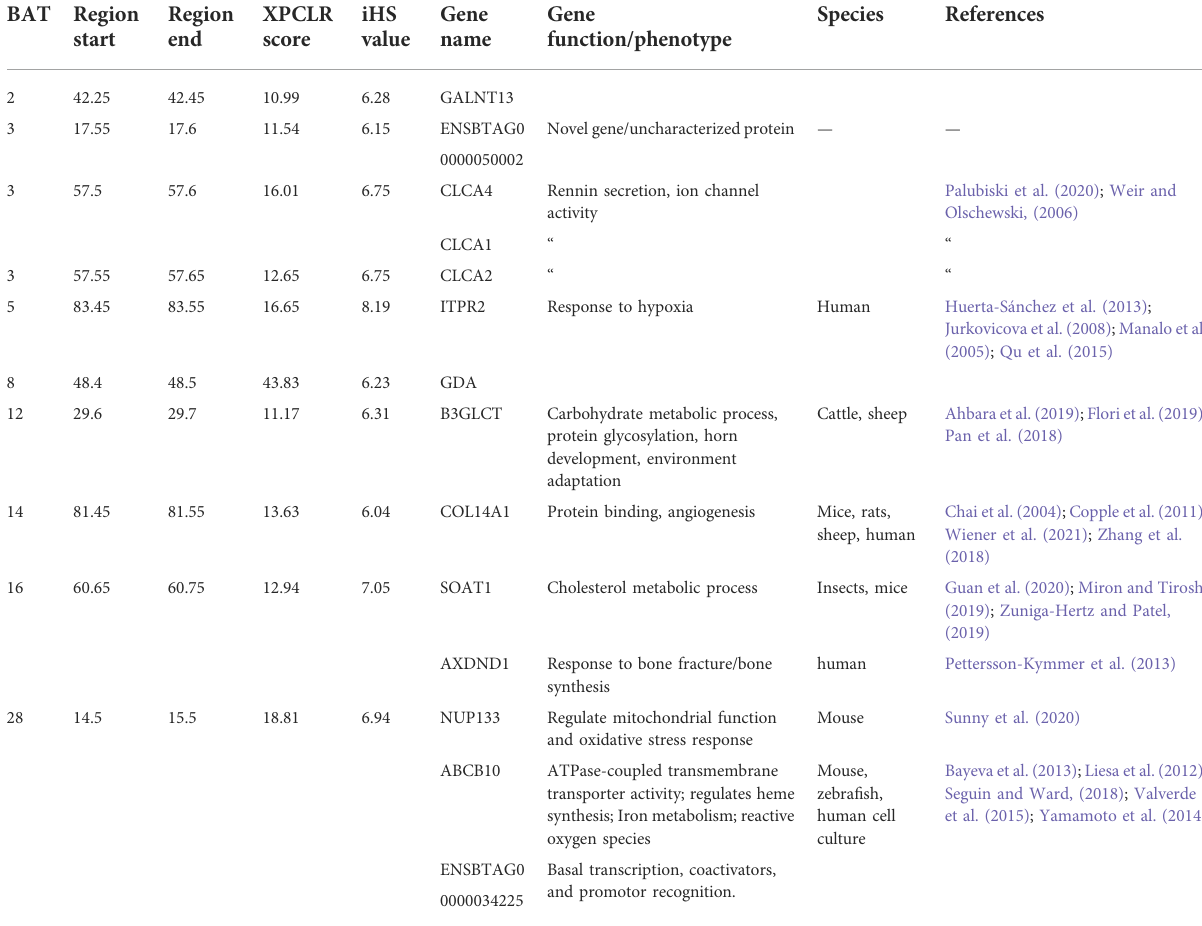
TABLE 2 List of overlapping regions and candidate genes identi fi ed using the iHS and XPCLR selection scan methods including, gene functions in reported species. BAT Region